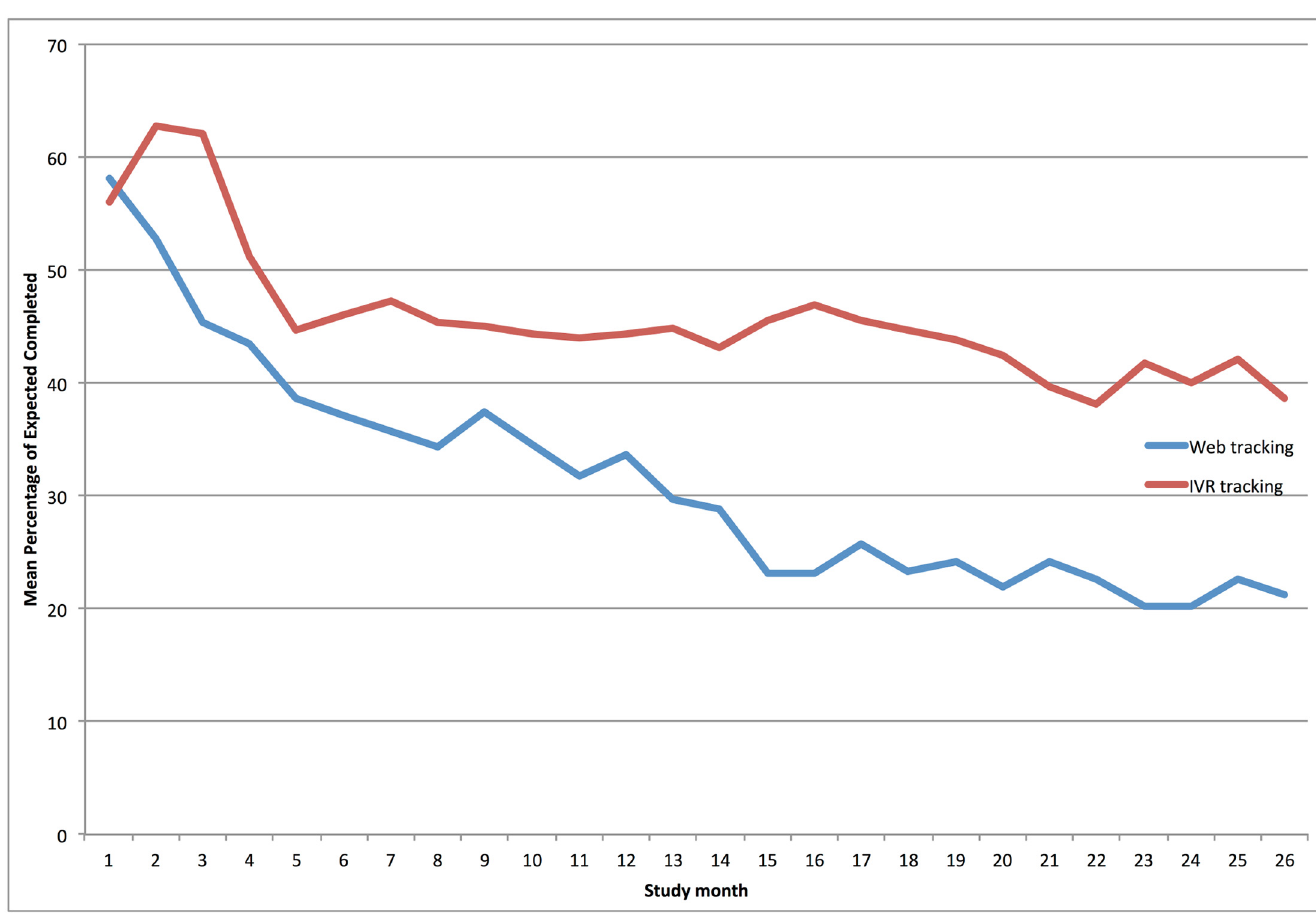
Fig 1. Mean percentage of self-monitoring completion over a four-week period in Be Fit Be